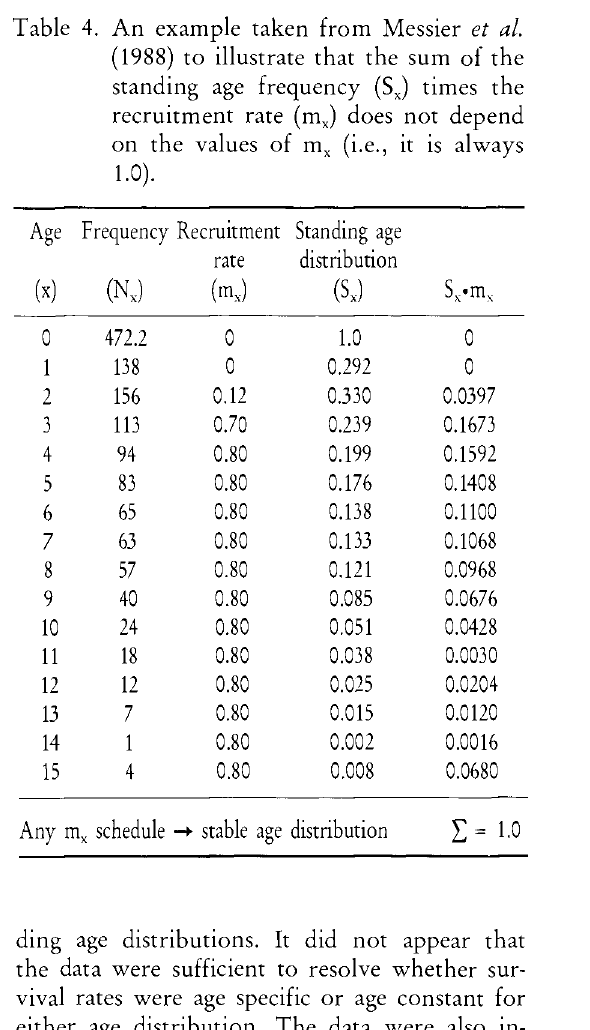
Table 4. An example taken from Messier et al. (1988) to illustrate that the sum oi the standing age frequency (S recruitment rate (m on the values of m